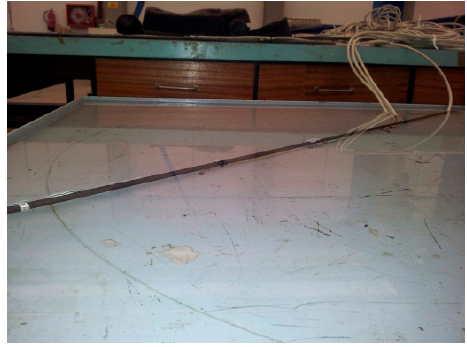
Figure 7. Sealing testing with sensors immersed in water.